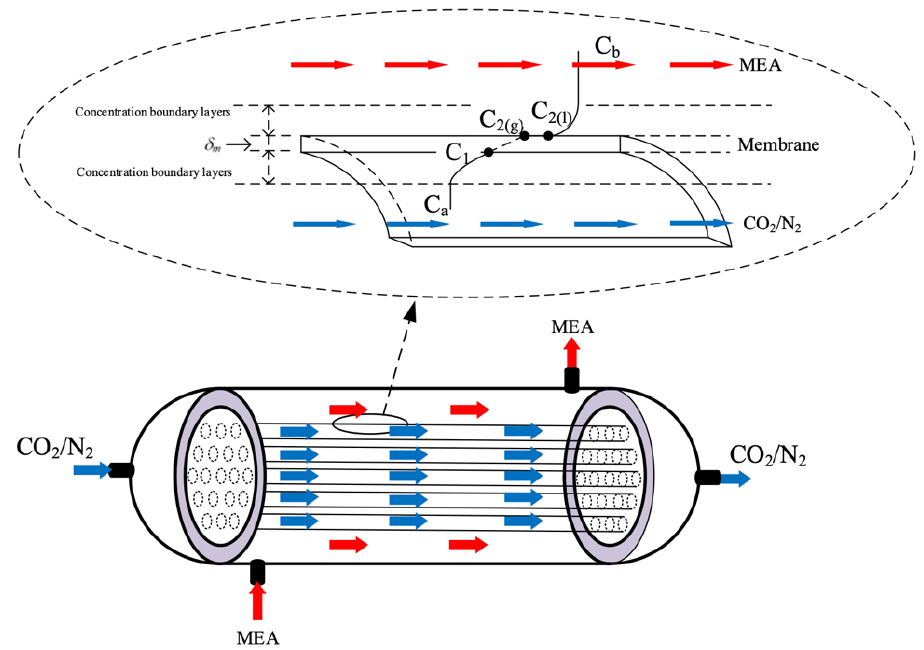
Figure 3. Schematic diagram of concentration boundary layers in a membrane contactor (Both red and blue arrows indicate the flow directions of MEA feed stream and CO 2 /N 2 feed stream, respec- tively).